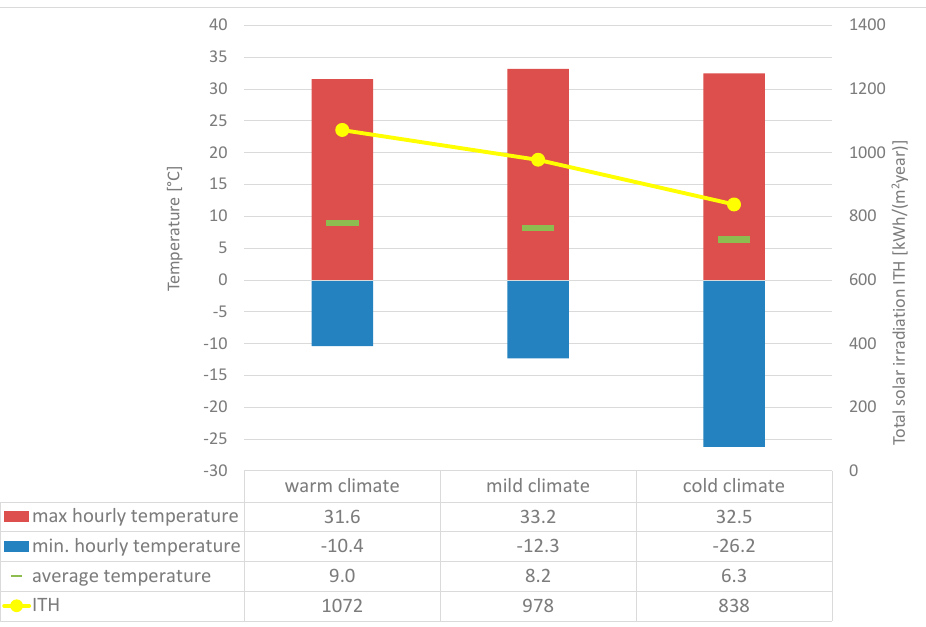
Figure 1. Characteristic parameters of the climate (ITH is the sum of total irradiation on a horizontal surface).